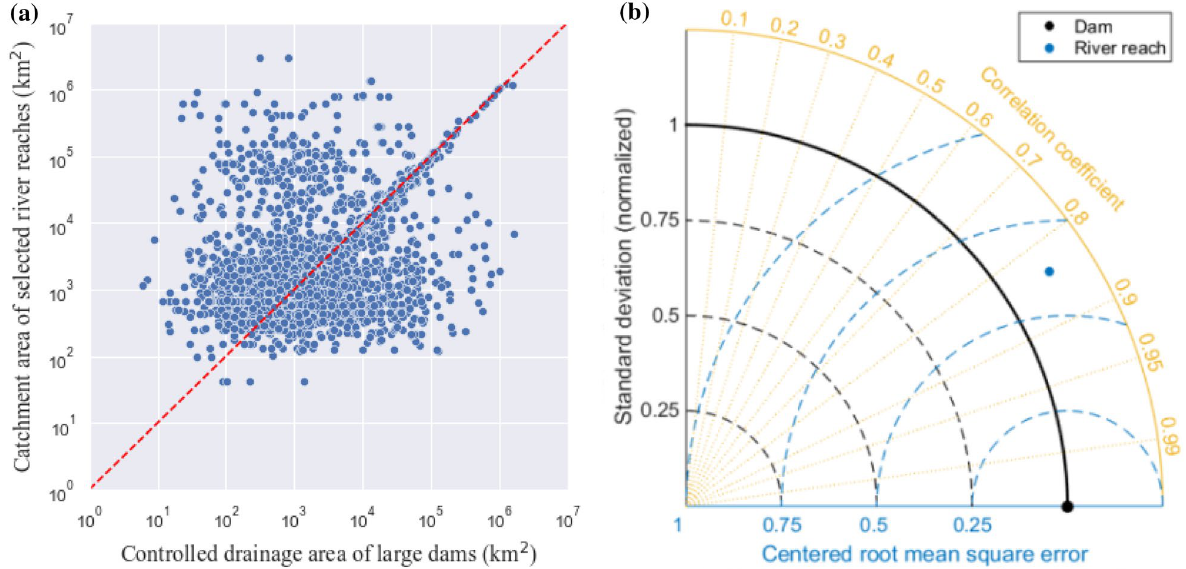
Fig. 3 a Comparison of the controlled drainage area values of the existing large dams and the catchment area values of the corresponding river reaches and b normalized Taylor diagrams displaying the differences between the controlled drainage area values of the existing large dams and the catchment area values of the corresponding river